Question: Compose a caption that would accompany this figure in a paper.
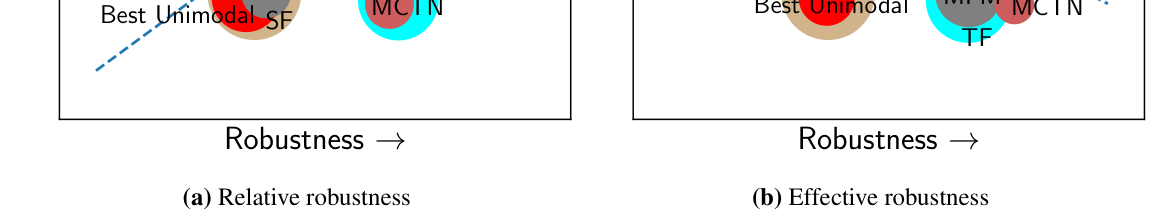
Answer: 4: Relative performance of each model across in-domain (red dots) and out-domain datasets (blue dots). In-domain refers to the performance on datasets that the method was previously proposed for and out-domain shows performance on the remaining datasets. We find that many methods show strongest performance on in-domain datasets which drop when tested on different domains, modalities, and tasks. In general, we also observe high variance in the performance of multimodal methods across datasets in MULTIBENCH, which suggest open questions in building more generalizable models.